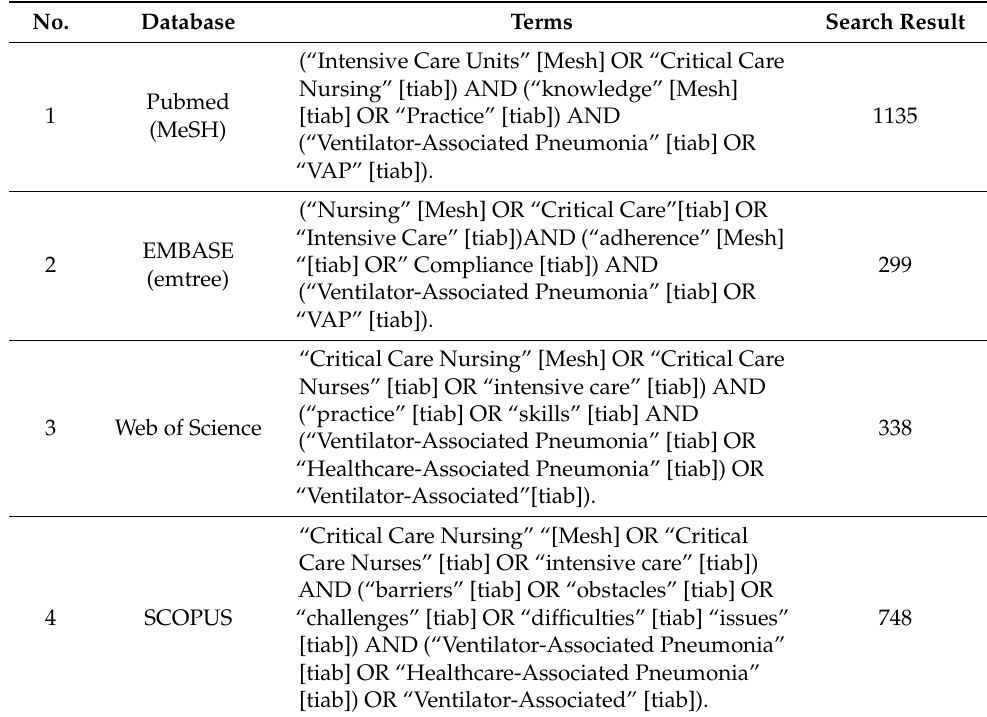
Table 1. List of terms used and search